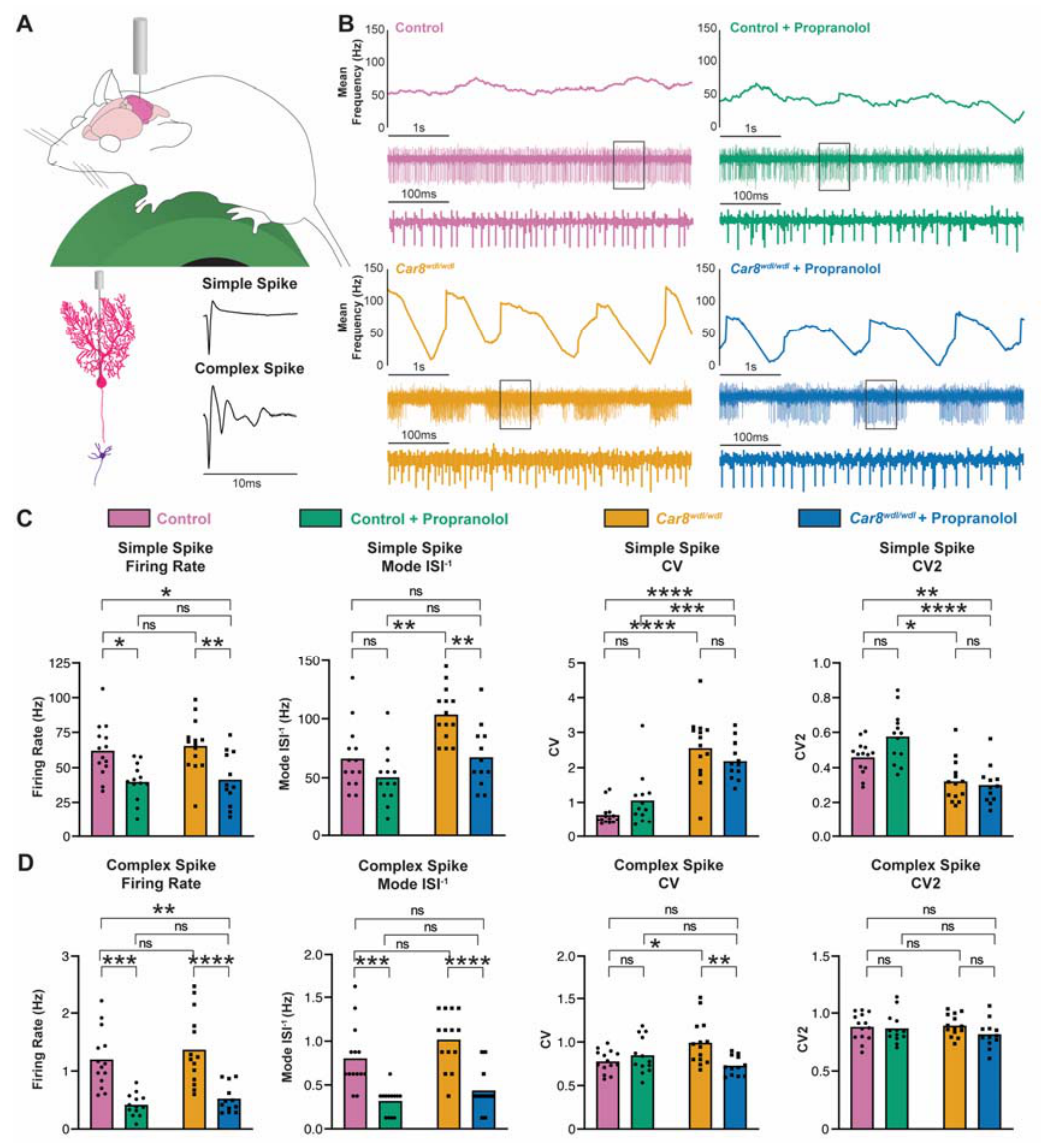
Figure 3. Propranolol modulates cerebellar Purkinje cell firing activity. ( A ) Top, schematic of awake in vivo electrophysiology recording setup. Bottom, illustrations of a Purkinje cell (bright pink), and downstream cerebellar nuclei neuron (purple), and the two different types of action potentials Purkinje cells produce—simple spikes and complex spikes. ( B ) Representative raw electrophysiologi- cal traces of Purkinje cell activity in control mice before (pink, N = 8, n = 14) and after propranolol treatment (green, N = 5, n = 13), and Car8 wdl/wdl mice before (gold, N = 6, n = 14) and after propranolol treatment (blue, N = 4, n = 12). The line graph shown at the top for each condition represents the mean firing rate in Hz at each point in time for the 5 s spike traces shown below each line graph. Below the 5 s spike traces are magnified views of the spikes within the outlined boxes, spanning 500 ms. The same color assignment for each group is maintained throughout the remaining figure panels (legend above electrophysiology graphs). ( C ) Quantifications of Purkinje cell simple spike firing activity. Propranolol significantly reduces simple spike firing rate in both control and Car8